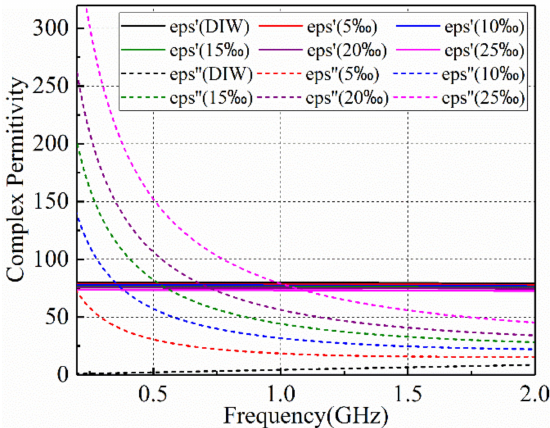
Figure 2. The complex permittivity of the saline solution at room